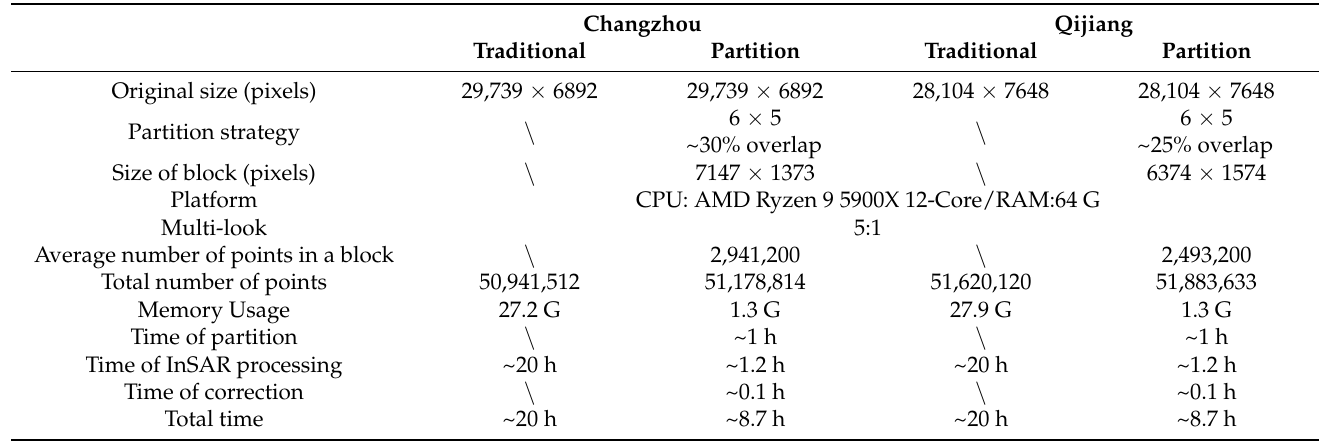
Table 3. Time and memory consumption of traditional processing and block processing with the number of parallel processing